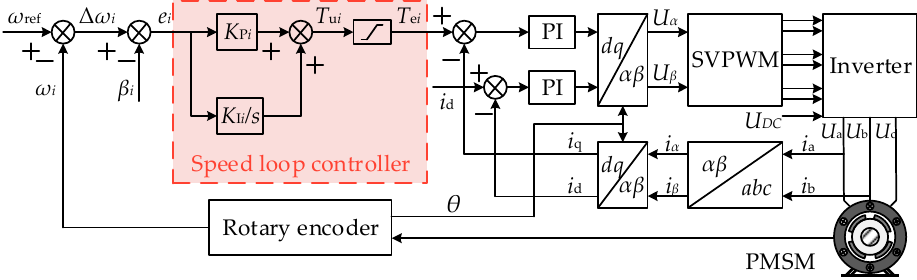
Figure 2. Control system of double closed-loop permanent magnet synchronous motor (PMSM).